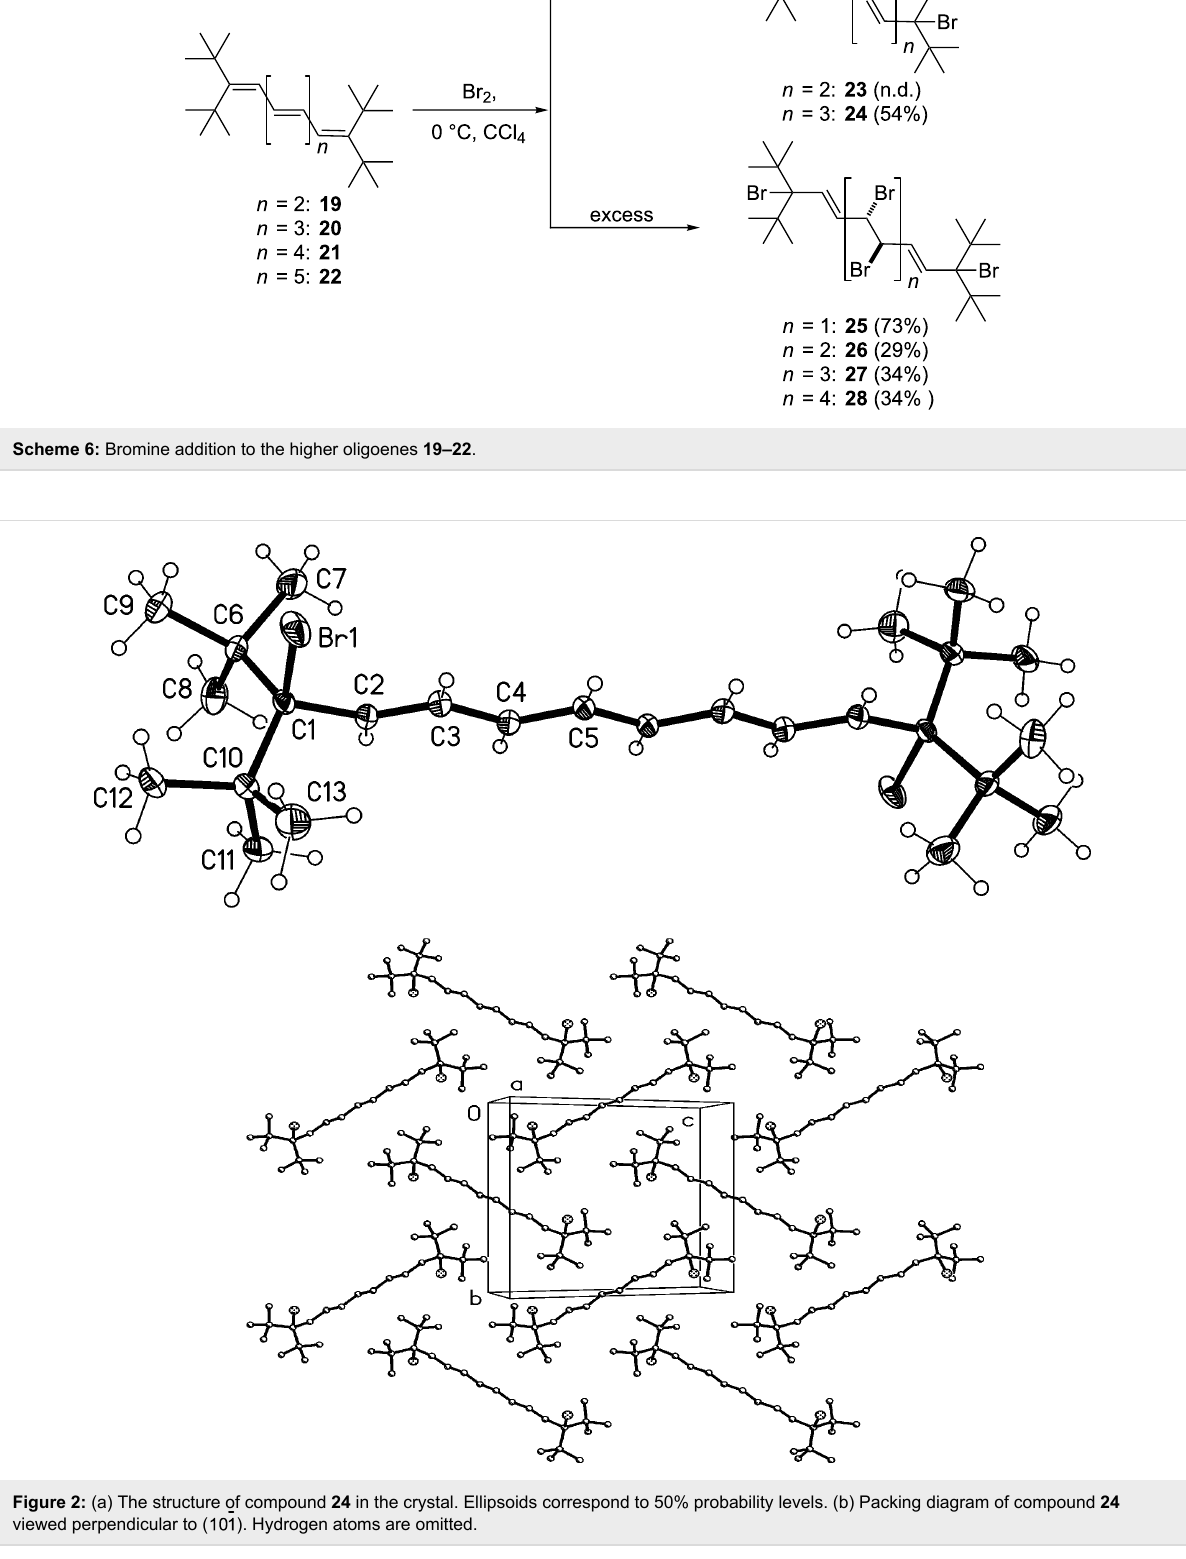
Figure 2: (a) The structure of compound 24 in the crystal. Ellipsoids correspond to 50% probability levels. (b) Packing diagram of compound 24 viewed perpendicular to ( ). Hydrogen atoms are